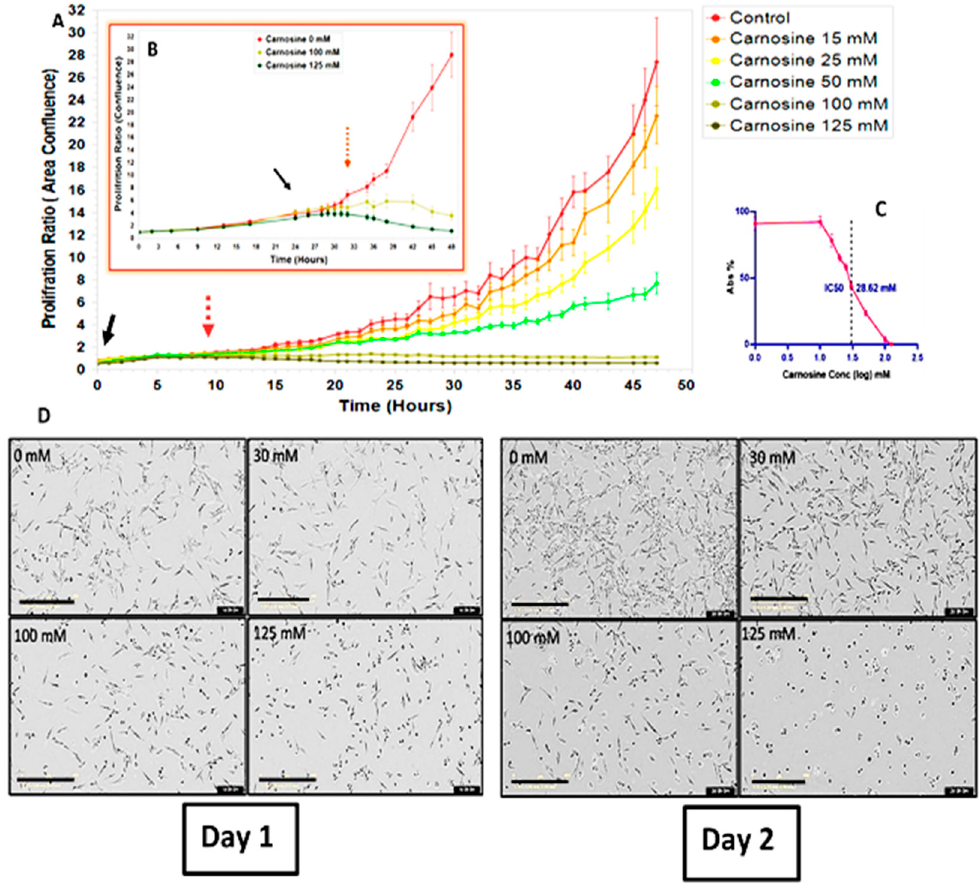
Figure 6. IncuCyte S3 live cell system (10×) Live cell images analysis shows ( A ) proliferation curves of the confluence ratio of U87 cells upon carnosine exposure over 48 h. Cells were treated with different concentrations between 0 and 125 mM. ( B ) To prove the same effect of carnosine on cell proliferation, a supportive study was applied with delayed carnosine addition until 24 h for 0, 100 and 125 mM. In both cases ( A , B ), the treatment effect started after 8 h. A MTT cell viability assay was conducted on the U87 cell line with different carnosine concentrations. ( C ) The absorbance at different concentrations refers to (IC50 = 28.62 mM) and (IC90 = 79.43 mM). Error bars represent SEM. The test was applied on the same six samples at the end point of the proliferation study. ( D ) The images of the critical carnosine concentrations are shown. Each image was displayed as the phase of U87 cells upon carnosine exposure over 1 and 2 days. Scale bars are 400 μ m.